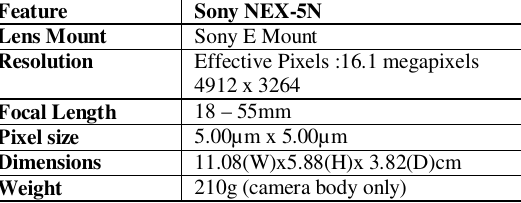
Table 2. Specification of Sony NEX-5N